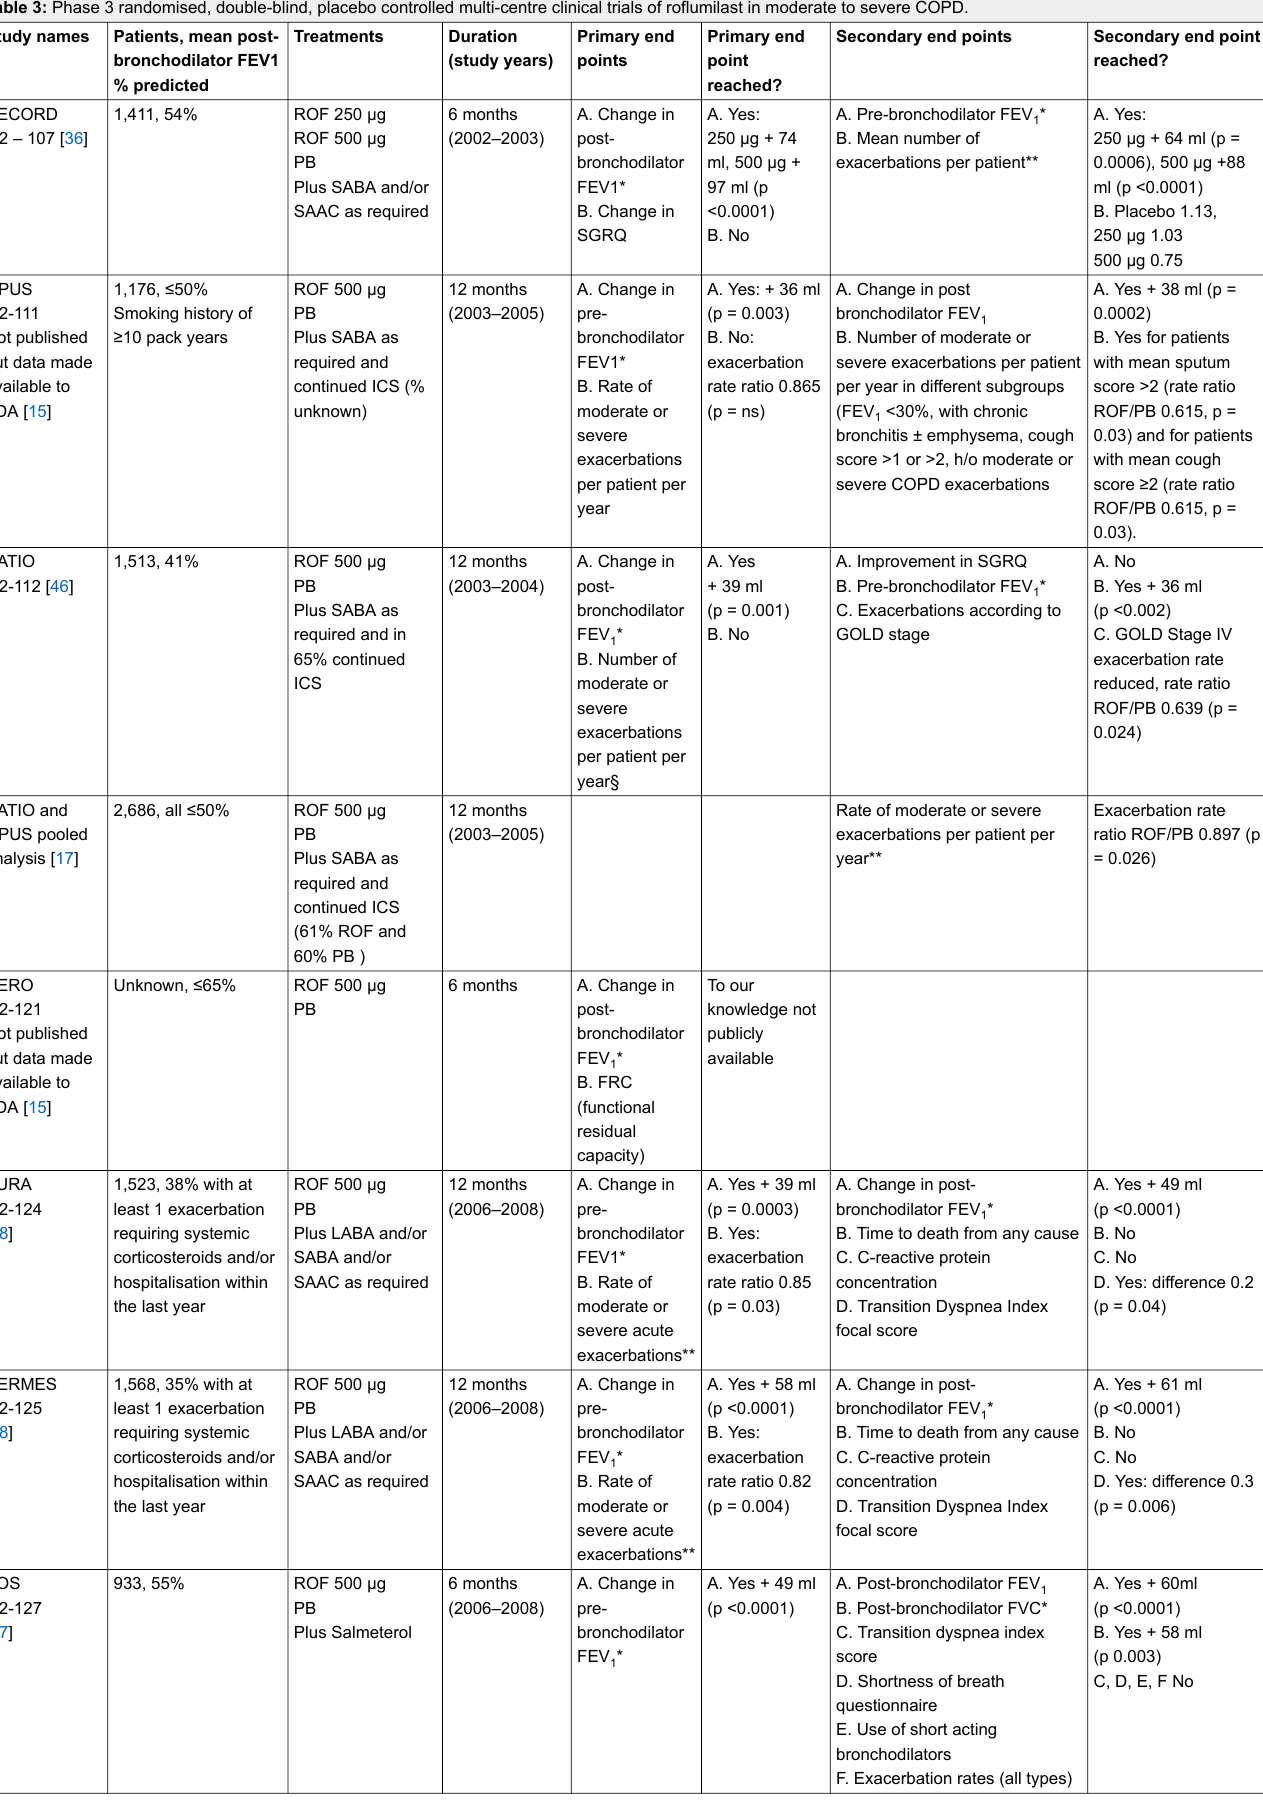
Table 3: Phase 3 randomised, double-blind, placebo controlled multi-centre clinical trials of roflumilast in moderate to severe COPD. Study names Patients, mean post- bronchodilator